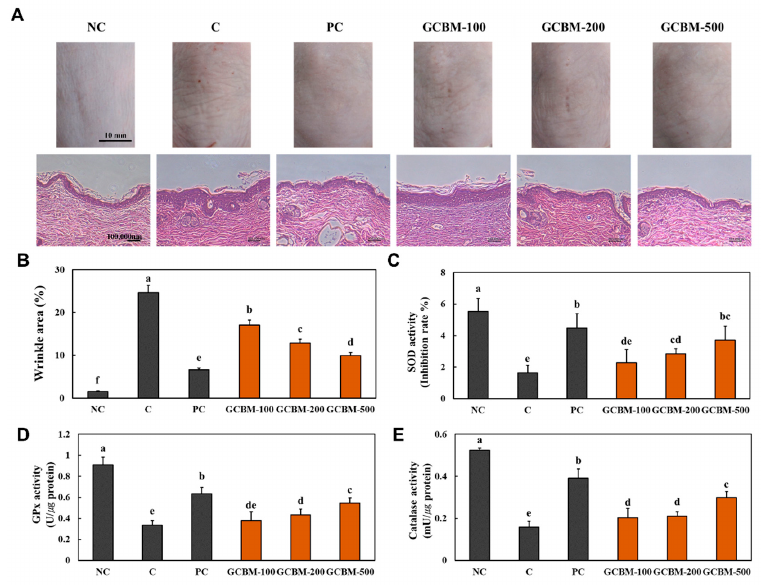
Figure 1. Effects of GCBM on morphological and histopathological changes ( A ), wrinkle area ( B ), and antioxidant activities of SOD ( C ), GPx ( D ), and catalase ( E ) in the dorsal skin of UVB irradiation- induced photoaging in mice. Normal control (NC), control (C; UVB-irradiation), positive control (PC; UVB-irradiation with diet containing L -ascorbic acid at 100 mg/kg/body weight [b.w.]), GCBM- 100 (UVB-irradiation with dietary supplementation of GCBM at 100 mg/kg/b.w.), GCBM-200 (UVB- irradiation with dietary supplementation of GCBM at 200 mg/kg/b.w.), and GCBM-500 (UVB-irra- diation with dietary supplementation of GCBM at 500 mg/kg/b.w.). Values are presented as mean ± SD. Different letters (a > b > c > d > e > f) indicate a significant difference, with 𝑝 < 0.05, as determined with Duncan’s multiple range test.